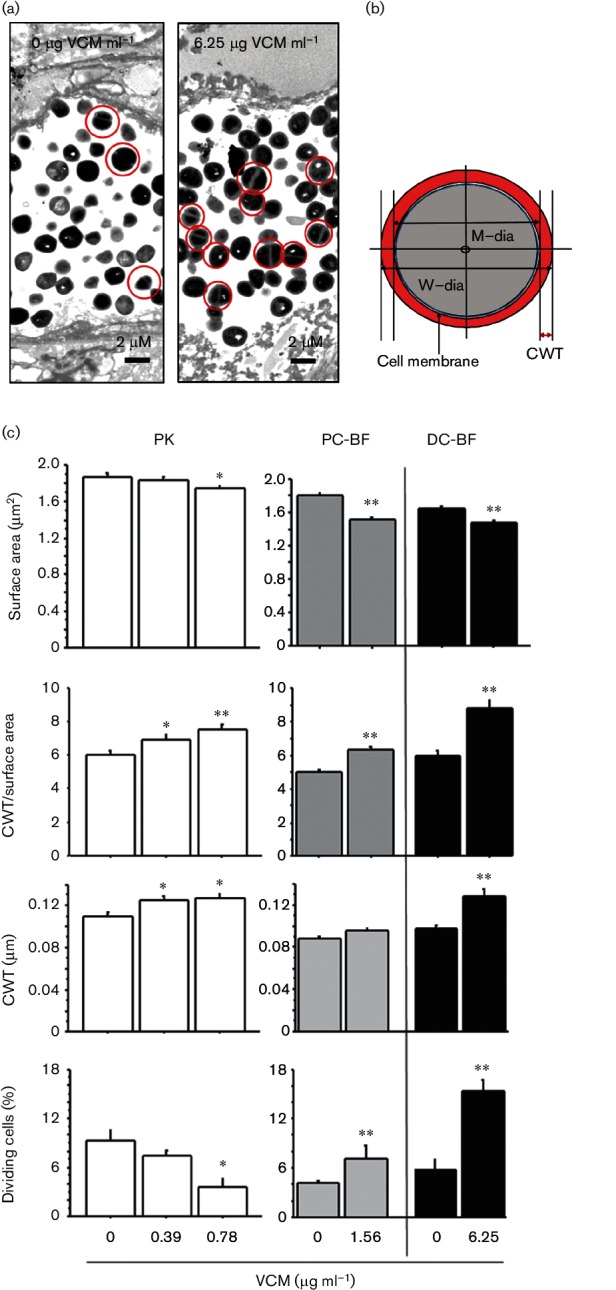
Morphometrical comparison of OJ-1 ultrastructure between different bacterial states. The effects of VCM on different bacterial states, namely PK cells, PC-BF and DC-BF, were assessed by electron microscopy. The cell division rate and several morphometrical parameters of cellular structure were evaluated. (a) Representative electron microscopic images of mitotic bacteria in DC-BF incubated without VCM (left) and with VCM (right). Dividing cells containing the metaphase plate are indicated by red circles. An increase in the number of dividing cells was found in the DC-BF incubated with VCM. Bars, 2 µm. (b) Diagram describing the structural elements used for the morphometrical analysis, including CWT, as described in detail in Methods. (c) Three different states of bacteria (PK cells, PC-BF and DC-BF) after VCM exposure were compared in terms of cell division and structural alterations, including CWT and surface area, calculated by use of the W-dia. The VCM concentrations used were lower than the MIC for each bacterial status. *, P<0.05; **, P<0.01.